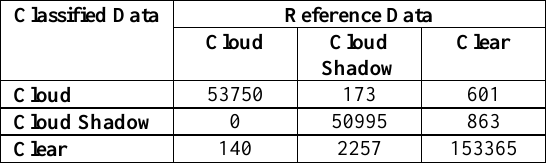
Table 2. Confusion matrix of the cloud and cloud shadow masking using MCM algorithm